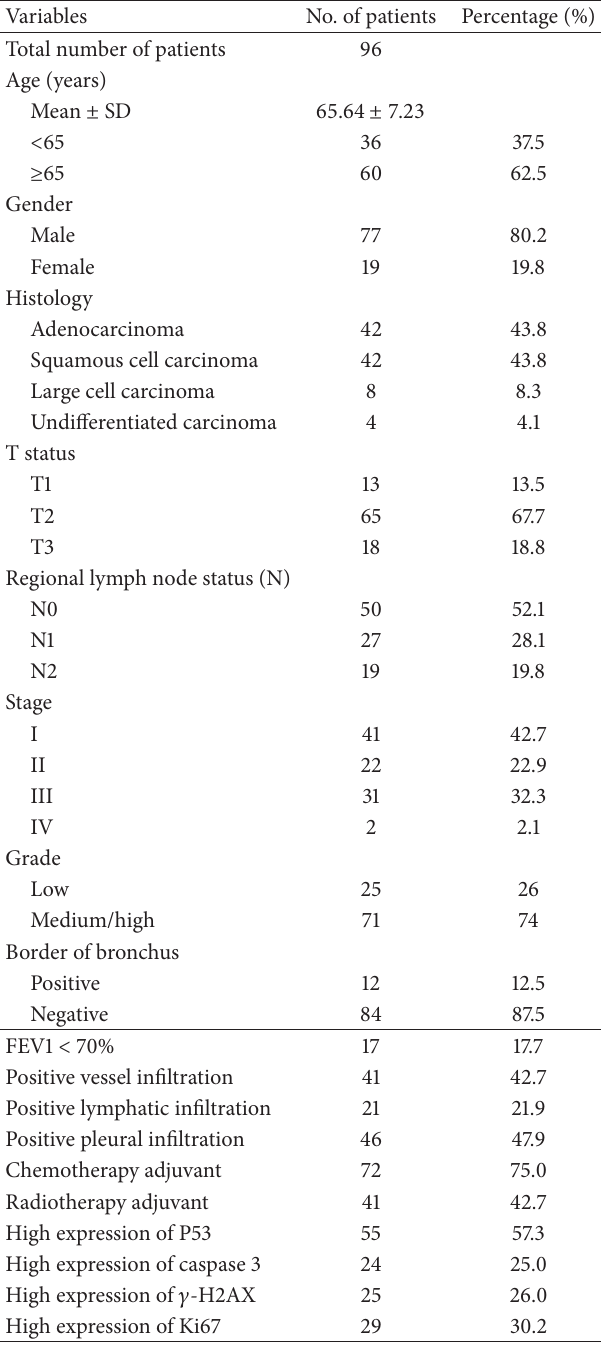
Table 1: Characteristics of the prediction